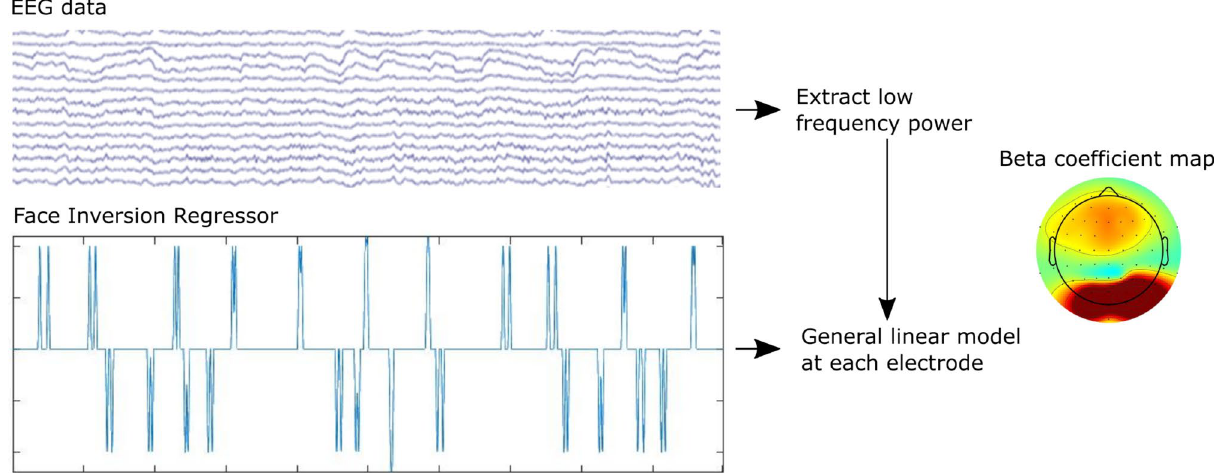
Figure 4. GLM-based approach. The preprocessed, continuous EEG signals were converted to low frequency power over time. A face inversion channel, the same length as the EEG data, was created where a positive spike occurred when an inverted face was seen, and a negative spike occurred when an upright face was seen. This channel was convolved with a 2 s hamming window to create the face inversion regressor. The low frequency EEG signals were modelled by the face regressor using a general linear model at each electrode, resulting in a beta coefficient map for each